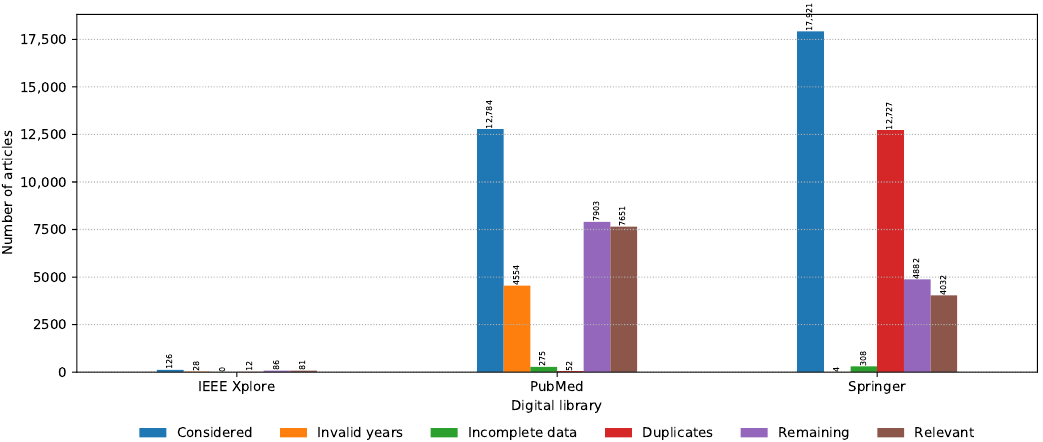
Figure 2. Number of articles collected and discarded in each PRISMA phase from each digital library.